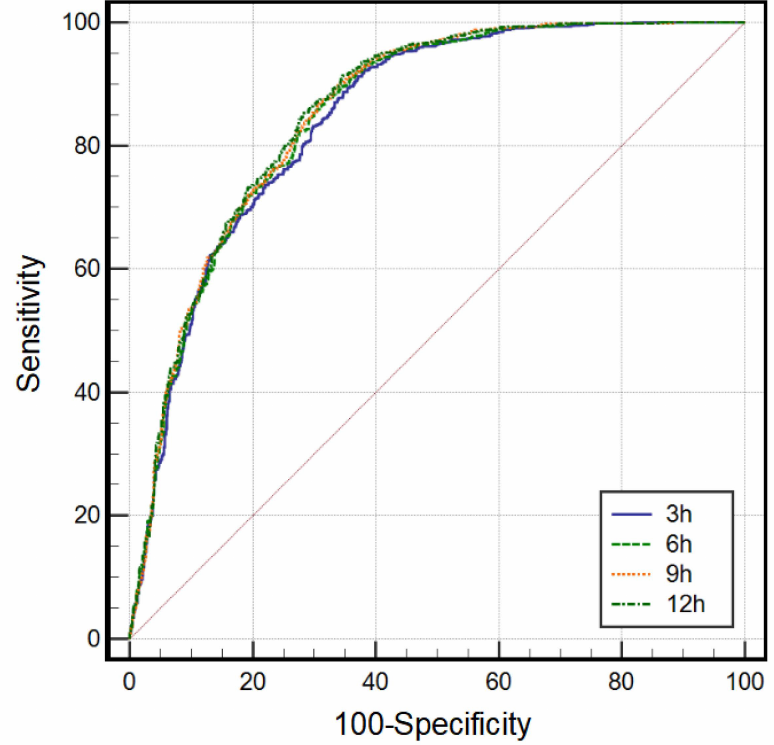
Figure 10. Receiver Operating Characteristic (ROC) curves of the flood hazard for the four rainfall duration